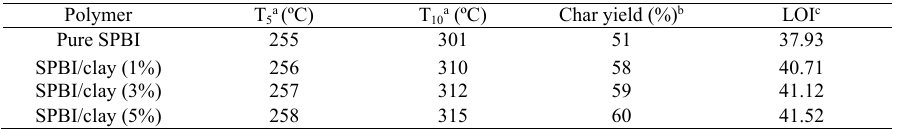
Table 1 Thermal characterizations of pure SPBI and SPBI/clay films Table 1. Thermal characterizations of pure SPBI and SPBI/clay films